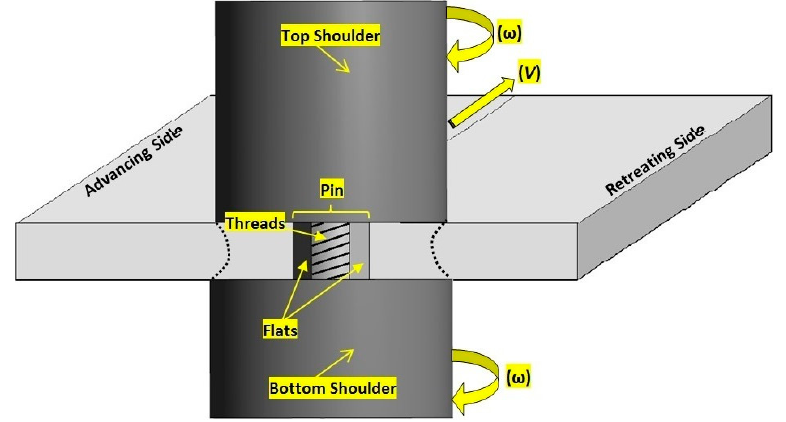
Figure 1. Schematic of the Bobbin Friction Stir Welding process; Bobbin-Tool in interaction with the workpiece as the substrate.